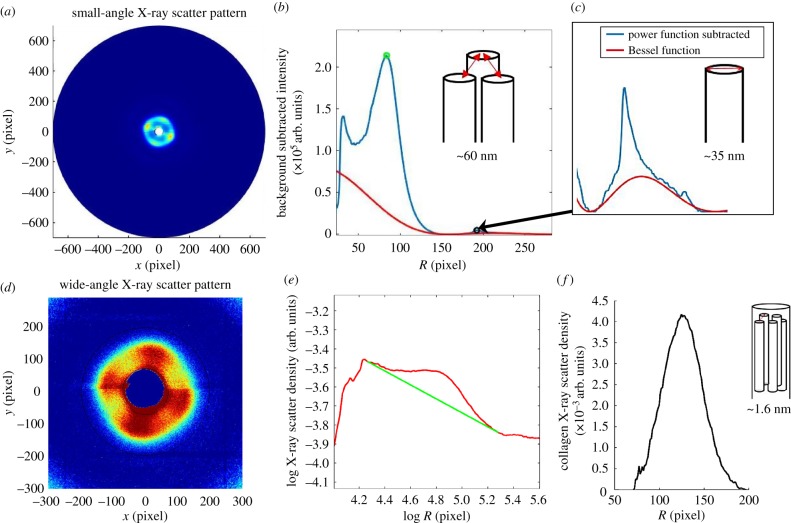
Analysis of X-ray scattering data. (a) The small-angle X-ray scatter pattern, which is circumferentially integrated to give a radial intensity profile. (b) Background-subtracted intensity profile (blue line), showing interference function peak (green circle) which provides a measure of the centre-to-centre separation distance of collagen fibrils. The fitted cylinder transform peak (Bessel function shown as a red line in b and inset c), which sits below the sharp third-order meridional reflection from corneal collagen, quantifies the average fibril diameter. (d) The wide-angle X-ray scatter pattern, which is circumferentially integrated around the collagen intermolecular reflection to give a radial intensity profile. (e) Radial intensity profile (red line), with fitted background function (green line). (f) The background-subtracted position of the intermolecular peak, once calibrated, gives a measure of the average collagen intermolecular separation.